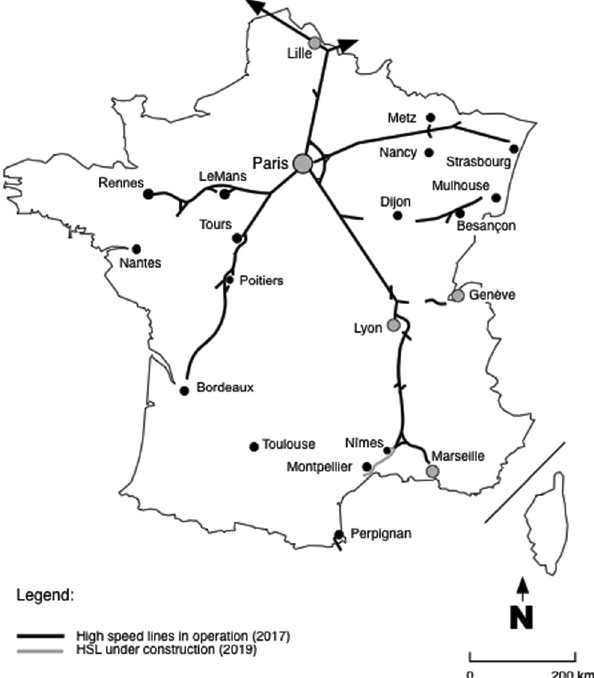
Fig. 2 Map of the HSL network currently in service or undergoing construction. Source: G. Zembri